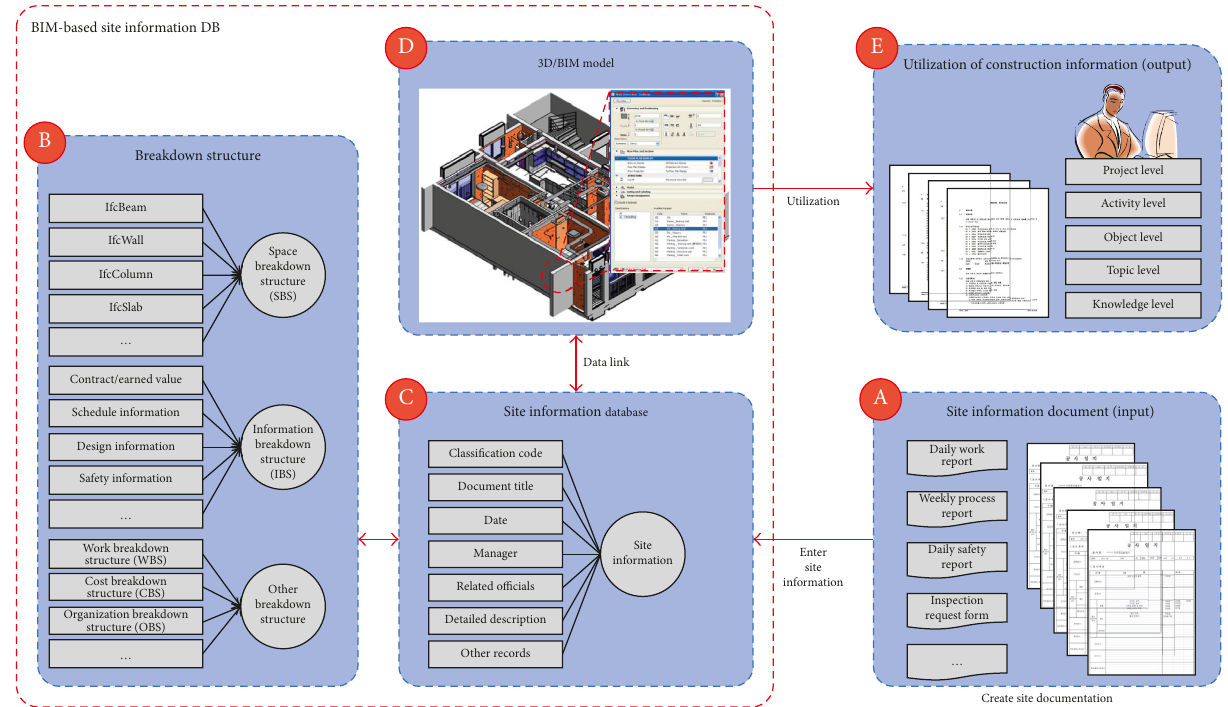
Figure 1: BIM-based construction database